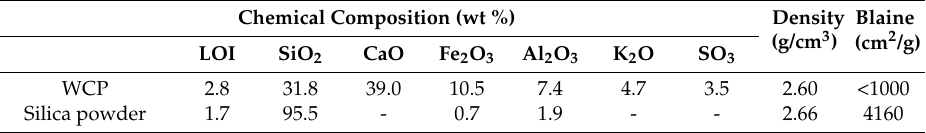
Figure 2. Particle size analysis of waste concrete powder (WCP).